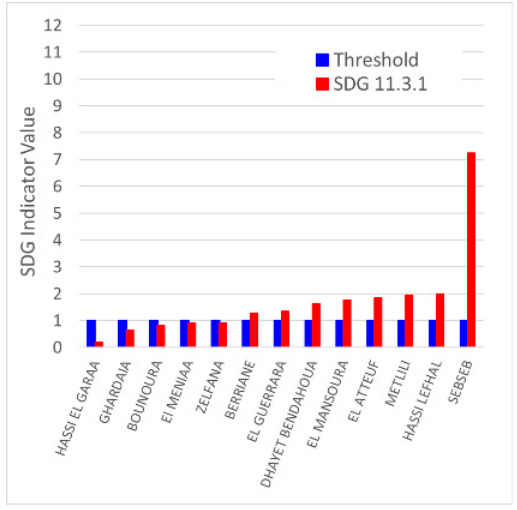
Figure 21. SDG 11.3.1 indicator values for the communes in the Ghardaia wilaya. The constant blue